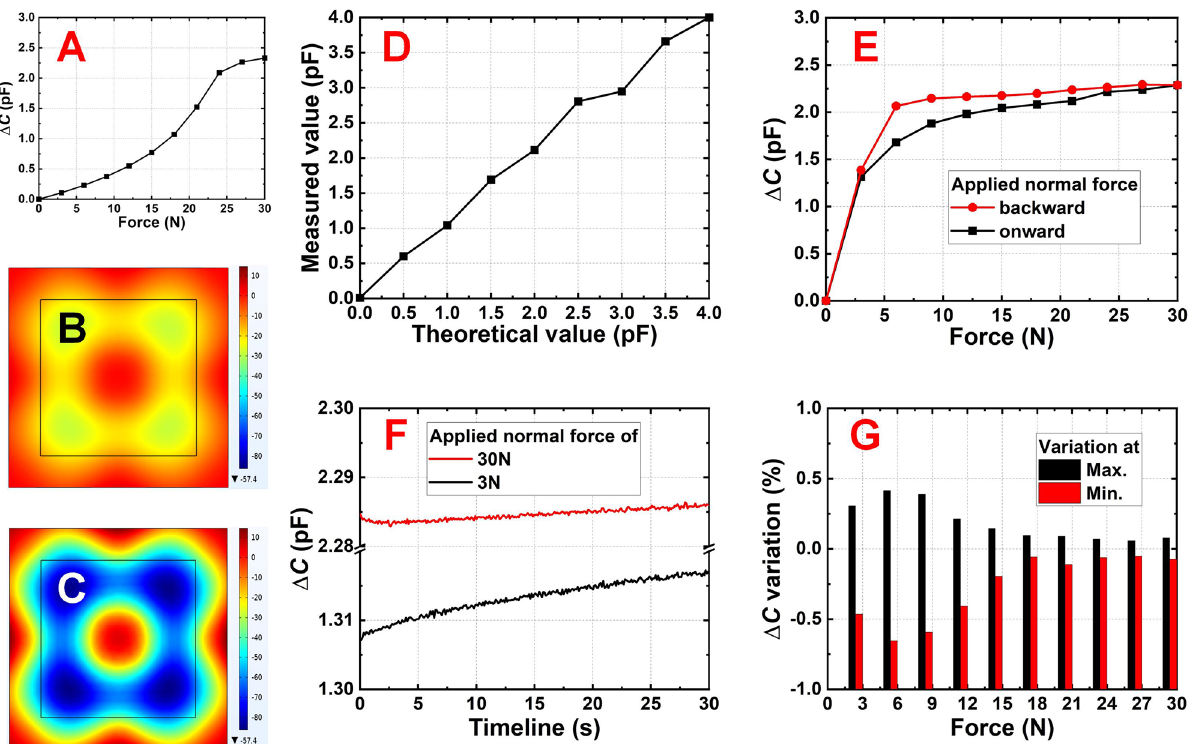
Figure 2. ( A ) The simulated F -Δ C relationship, in which a positive relationship was observable when the applied force was less than 24 N before signal saturation. The simulated top view structural deformations under ( B ) 10 N and ( C ) 30 N for the sensing unit. Enclosed areas in ( B ) and ( C ) indicate the electrode locations. Color legends in ( B ) and ( C ) are in μm. ( D ) Capacitive response of two commercialized ceramic capacitors in parallel that were sold with 2 pF capacitance values. ( E ) The fabricated sensing unit that shows hysteresis resulted from the elastomeric deformation and recovery. ( F ) The temporal Δ C stability when the applied force was low and high, and ( G ) its variation under different applied normal forces which shows the smallest and largest results under 27 N and 6 N,